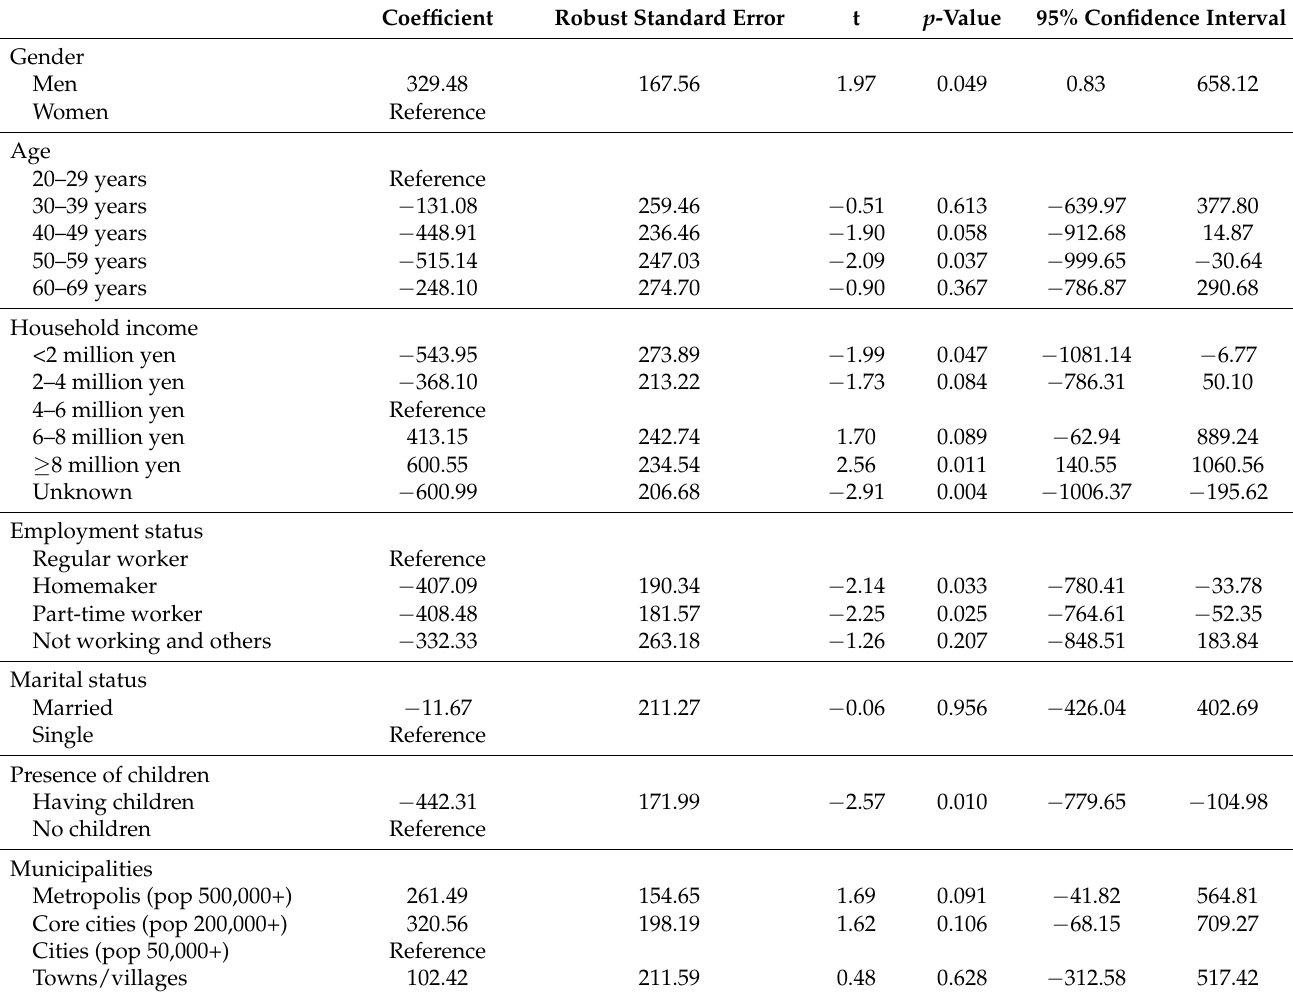
Table 3. Association between WTP values for dental checkups and study participants’ characteristics in the RDC group (multivariate Tobit regression